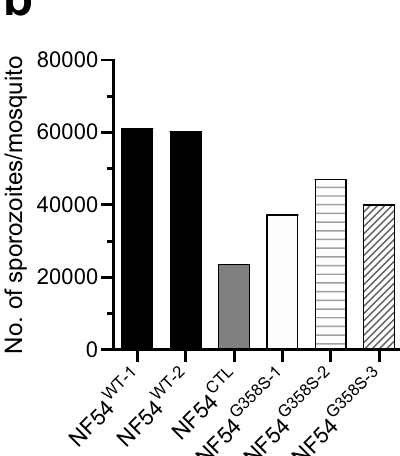
There was a small difference in oocyst numbers between NF54 WT and NF54 G358S ( P =0.04; Mann – Whitney test, two-tailed). There was a larger difference in oocyst numbers between NF54 WT and NF54 CTL (open squares; P =0.0007; Mann – Whitney test, two-tailed). P values ≤ 0.05 indicate statistical signi fi cance and are shown in bold. b Numbers of salivary gland sporozoites, determined on Day 16 post blood meal.Thedataarethemeannumberofsporozoitespermosquito.Foreachparasite line,20mosquitoesweredissected,theirsalivaryglandspooledandhomogenised, and sporozoites counted using a haemocytometer. Source data are provided as a Source Data fi